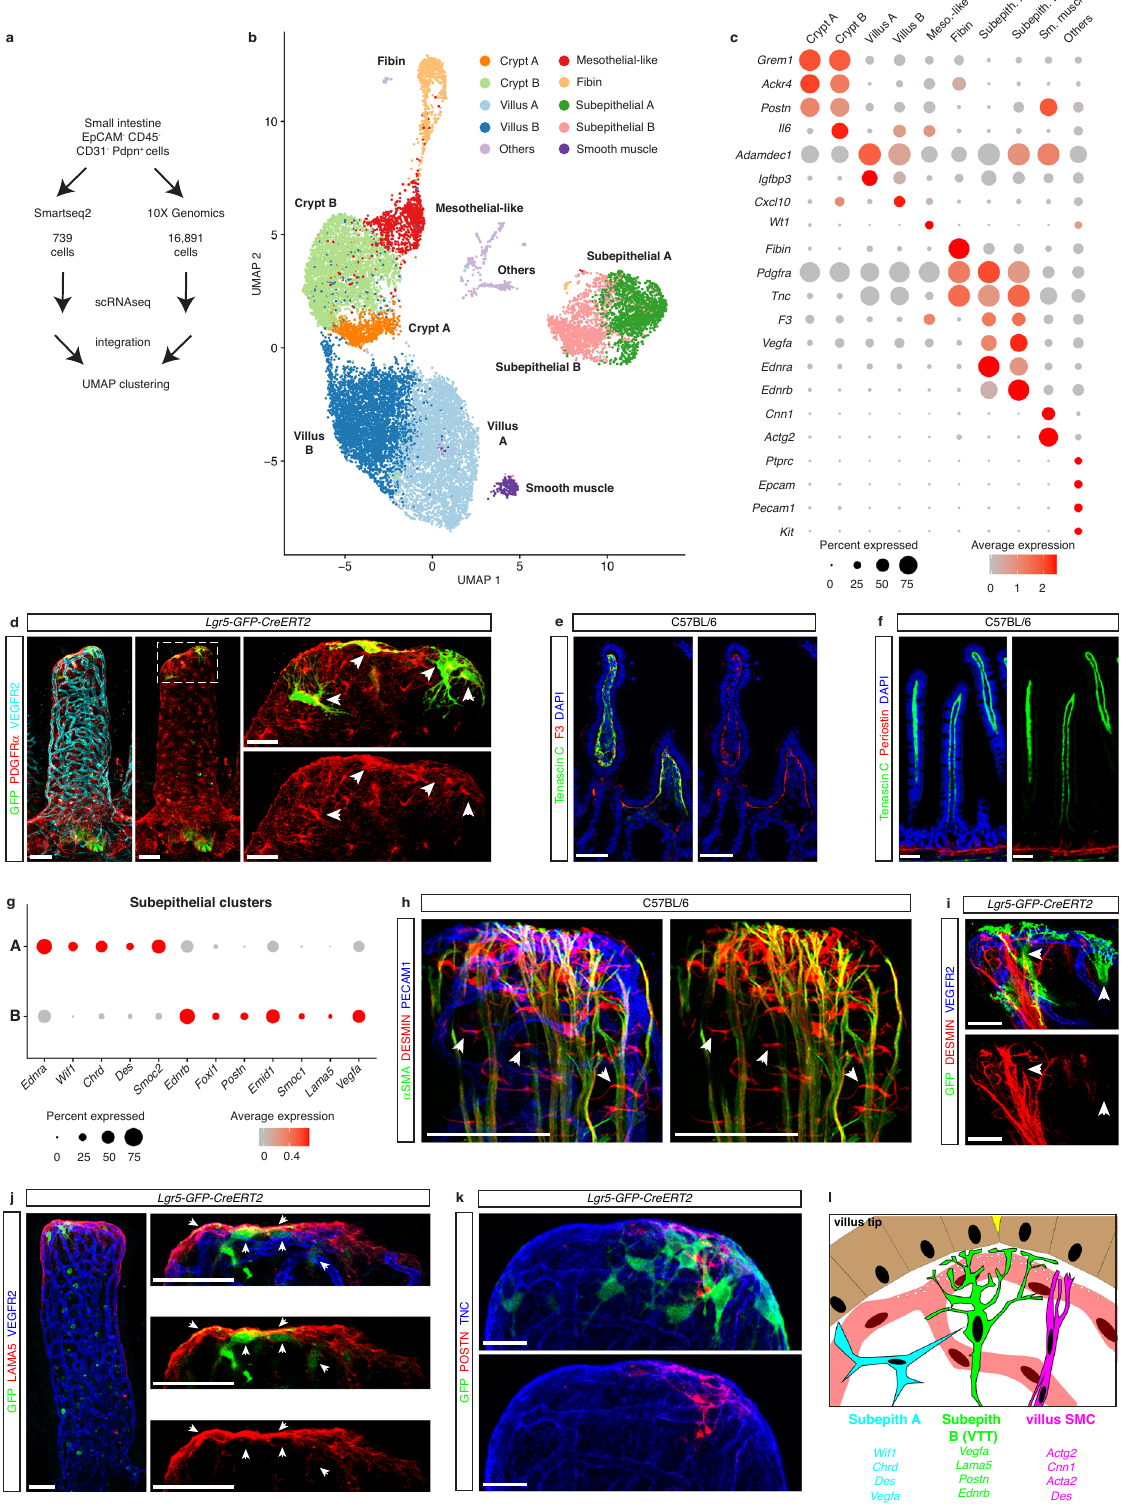
vessels than controls (Fig. 5g-i) and VEGFA protein levels were mice (Fig. 5c, e) and the number of fi lopodia-displaying increased at the villus tip (Fig. 5j). Moreover, there was a endothelial cells was increased (Fig. 5c, f), while length of the tendency towards increased portal vein VEGFA levels in villus lymphatic vessels, lacteals, were unchanged (Supplementary Adamts18 − / − mice compared to controls (Supplementary Fig. 7b). Fig. 7a). We therefore analyzed whether Adamts18 -de fi ciency altered villus tip endothelial cell VEGFA signaling. Both VEGFR3 Taken together these data indicate that Adamts18 de fi ciency leads and ESM1 were more highly expressed in Adamts18 − / − villus tip to loss of villus tip VEGFA sequestration and an increase in NATURE COMMUNICATIONS| (2022) 13:3983